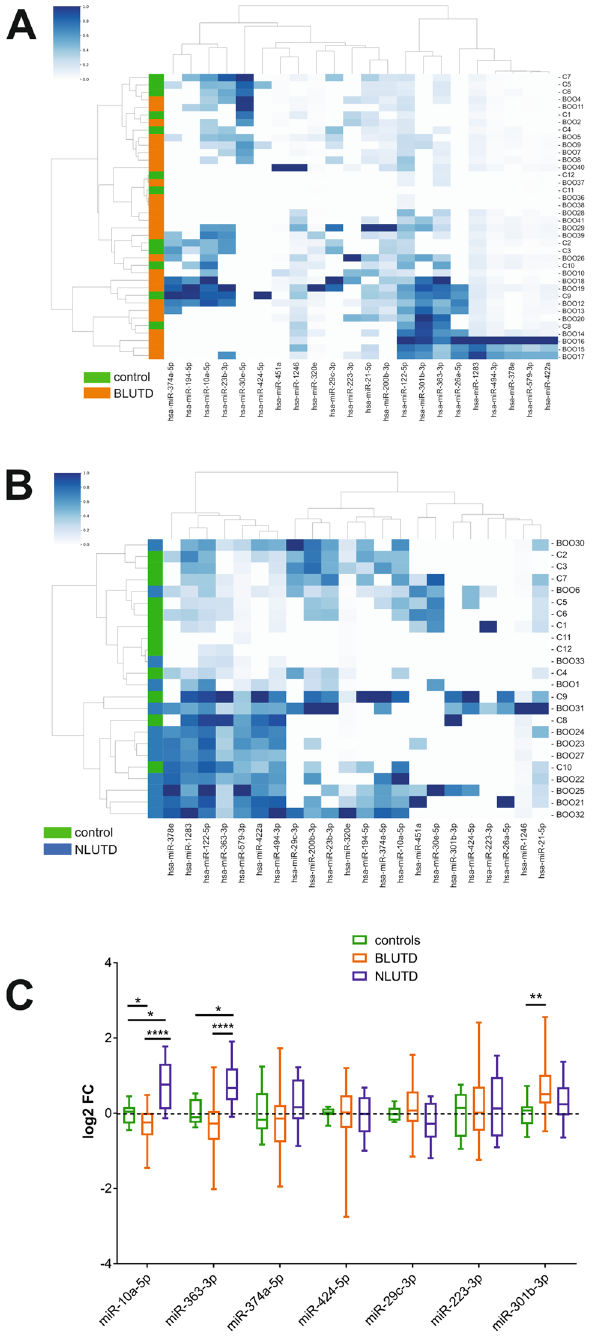
Figure 5. Urinary miRNAs miR-10a-5p, miR-363-3p and miR-301b-3p differentiate between controls and LUTD patients groups. RNA samples were derived directly from 50 ml of total cell-free urine, and miRNAs were profiled using NanoString and validated by RT-qPCR. (A) Hierarchical clustering and heatmap of 22 miRNAs expressed in the total urine of controls (“C”, n = 12) and patients with BLUTD (“BOO”, n = 26). Each column represents one miRNA and each row represents one sample. Expression levels are colour-coded (bar above, white for low and blue for high levels). Samples are colour-coded orange for BLUTD and green for control. (B) Hierarchical clustering and heatmap of 22 miRNAs expressed in the total urine of controls (“C”, n = 12) and patients with NLUTD (“BOO”, n = 12). Each column represents one miRNA and each row represents one sample. Expression levels are colour-coded (bar above, white for low and blue for high levels). Samples are colour-coded blue for NLUTD and green for control. (C) PCR validation for NanoString data for 7 regulated miRNAs, normalized to miR-320e. Boxplot of log2 fold change in patients with BLUTD (n = 30) and NLUTD (n = 11) relative to controls (n = 12) Ordinary 2 way ANOVA was used for multiple comparisons (*p ≤ 0.05, ** p = 0.0047, **** p <